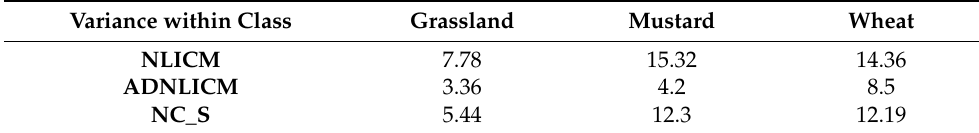
Table 16. Comparison of OA with different studies.